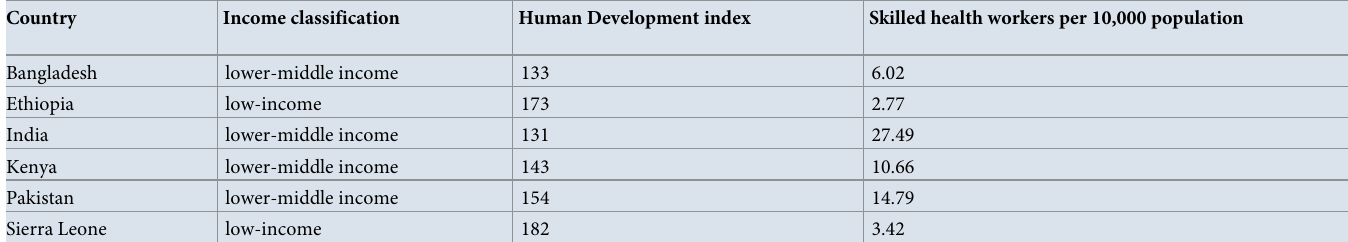
Table 1. Country development and health system status